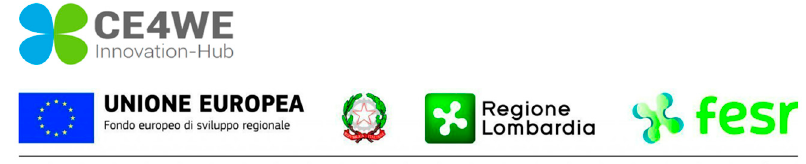
Table S2: EDX results for the MIP sample after template